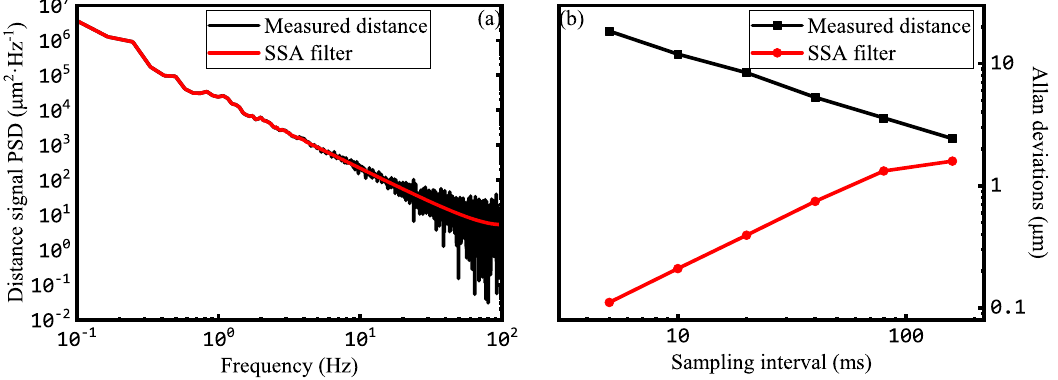
Figure 7. Spectral power density ( a ) and Allan deviation ( b ) of the distance